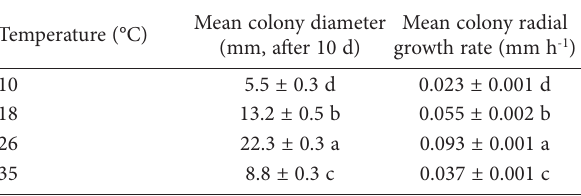
Figure 3. Healthy cucumber variety Nizhynskyi 12 plants (a - left, and b), and diseased plants (a - right, and c), after 14 d of